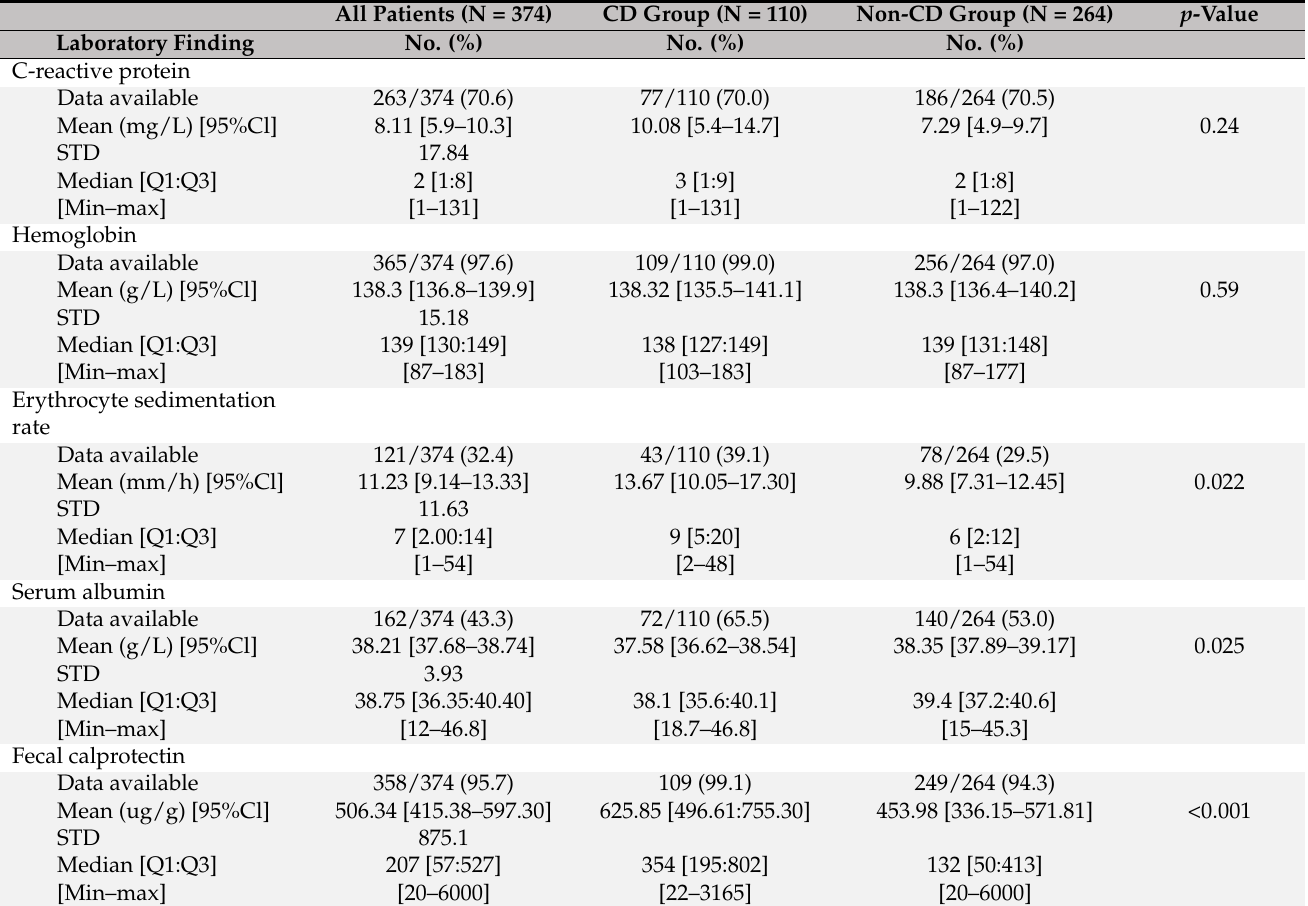
Table 3. Laboratory findings by